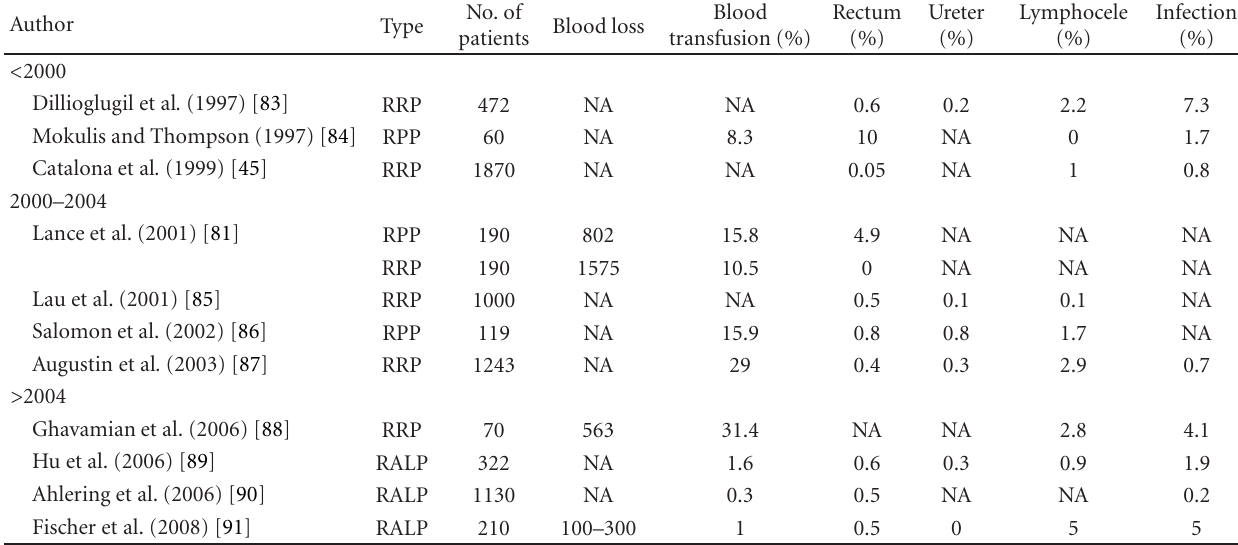
Table 3: Perioperative complications in di ff erent types of radical